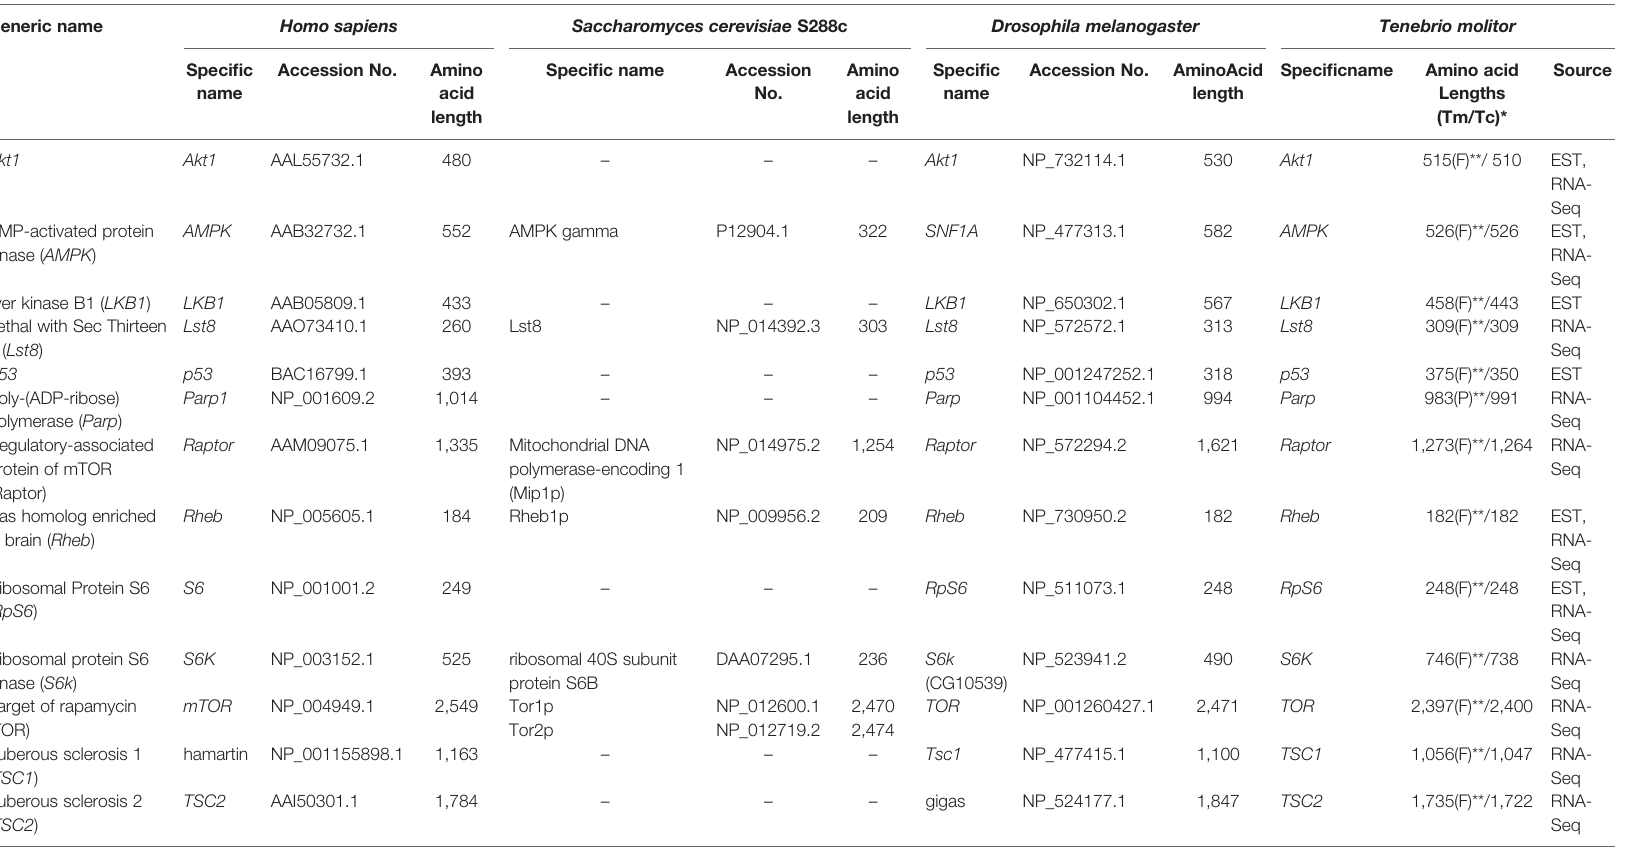
TABLE 1 | Up-stream autophagy signaling genes in T. molitor